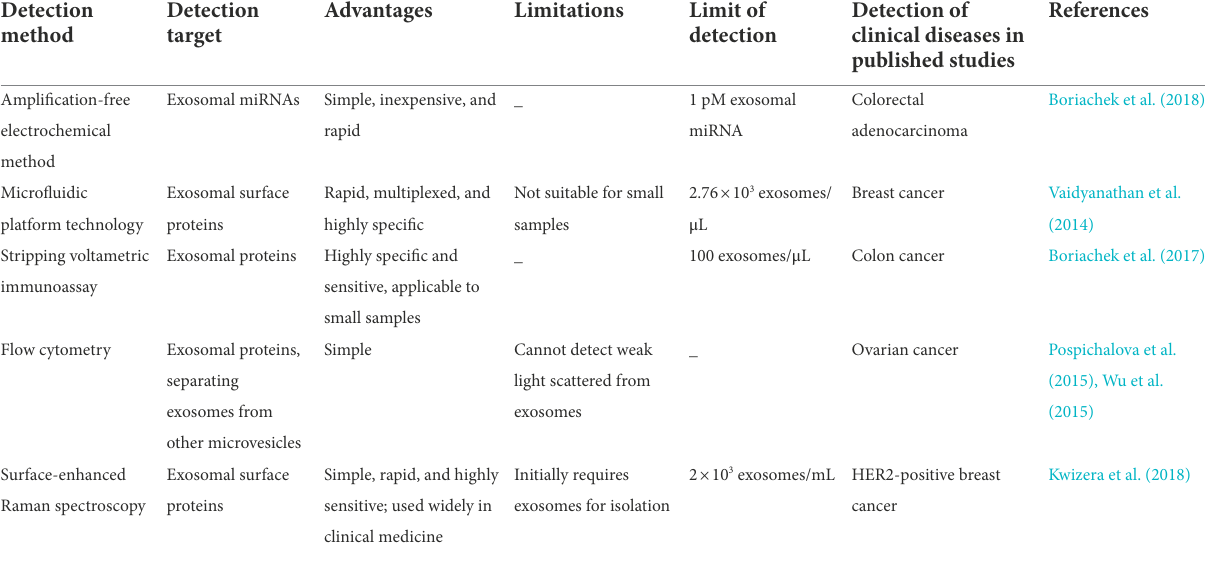
TABLE 1 Summary of new technologies for the detection of exosomal